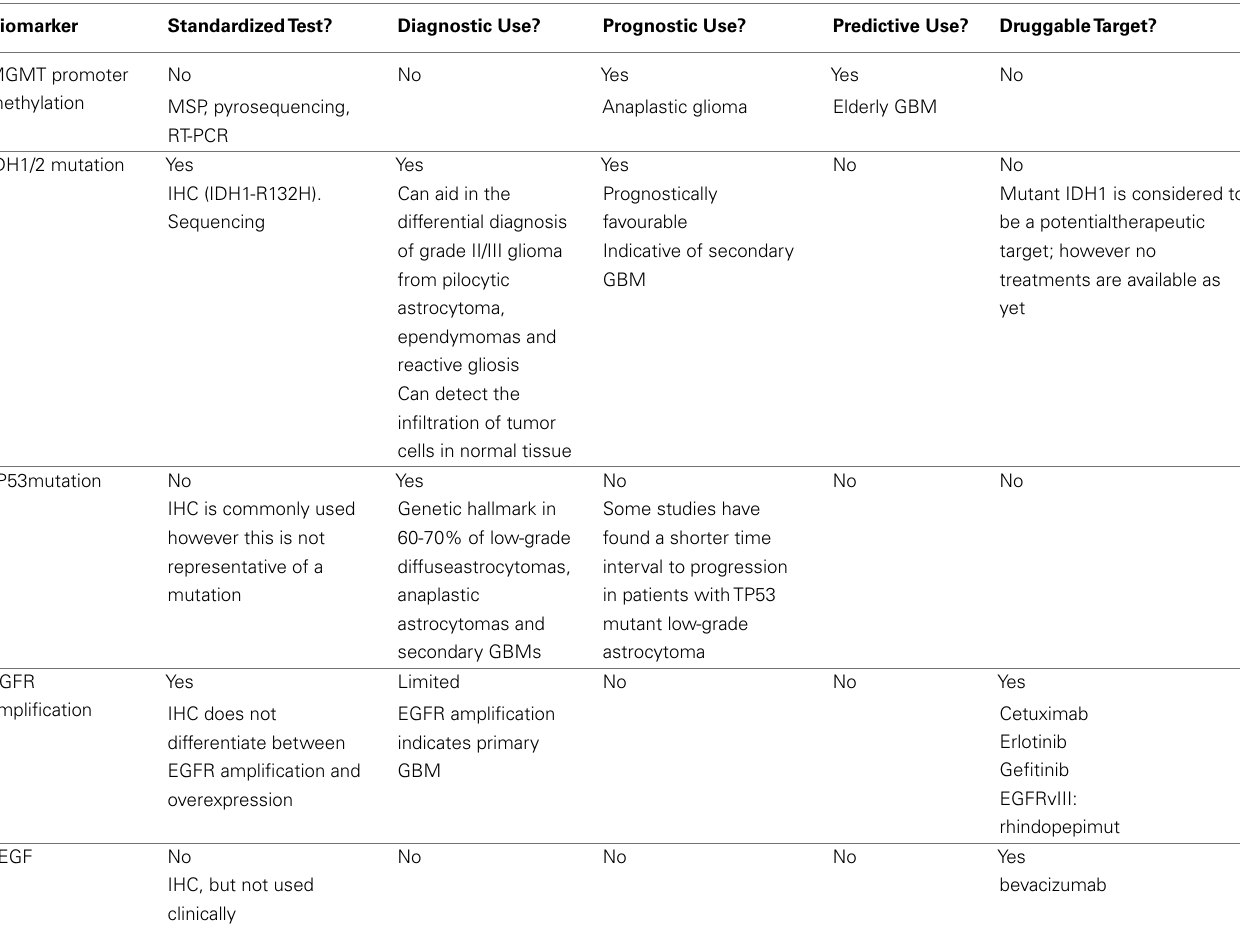
Table 1 | Biomarker